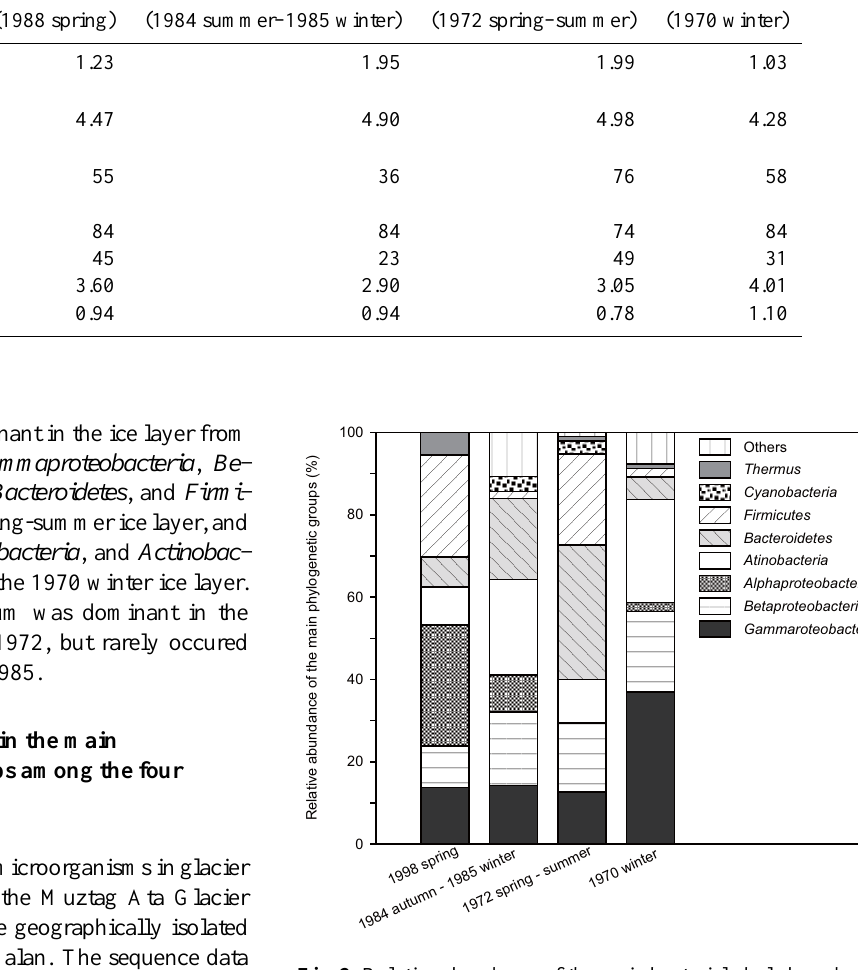
Fig. 2. Relative abundance of the main bacterial phyla based on the Blast result of 16S rRNA gene sequences in each of the clone li- braries in the four different ice layers along the Muztag Ata Glacier